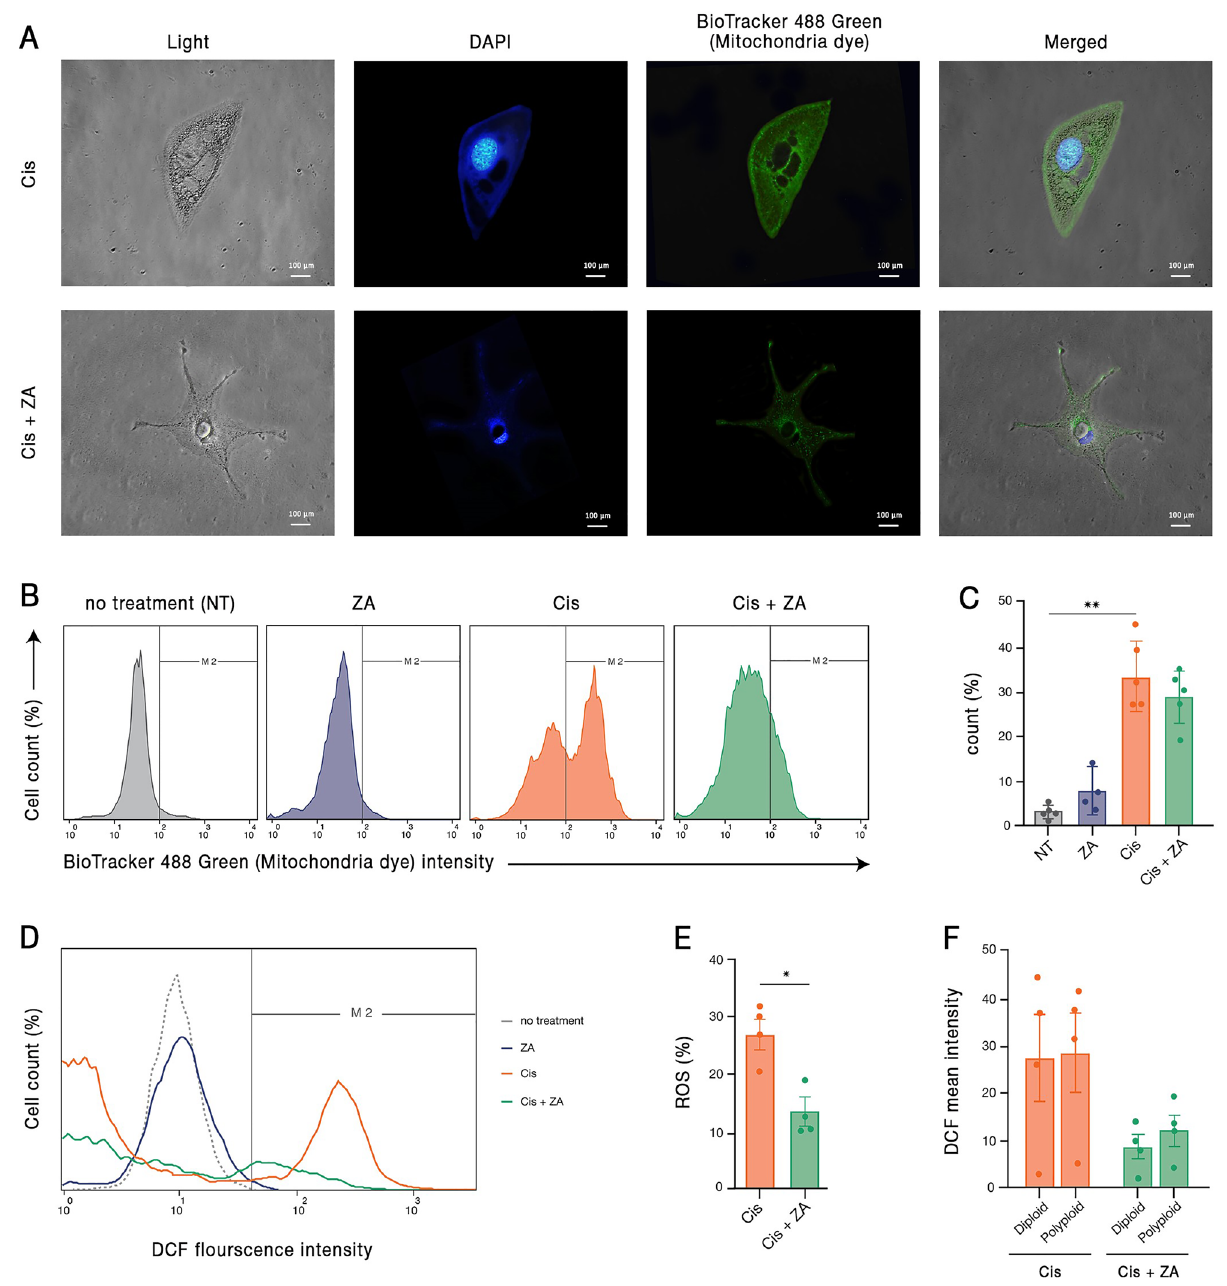
Figure 5. Cisplatin-surviving cells have high mitochondrial density and ROS content, both of which are reduced by ZA. ( A ) Representative images of mitochondrial staining of cancer cells treated with cisplatin or cisplatin + ZA are demonstrated. ( B ) Representative flow-cytometry graphs and ( C ) quantification of four independent experiments demonstrated the augmentation of mitochondrial density after cisplatin and the partial declining effect of ZA. ( D , E ) ROS content of cisplatin-survived cells is increased and is significantly diminished after ZA administration. ( F ) The effect of ZA in declining ROS in cisplatin-treated cells is observed both in diploid and polyploid sub-populations. * p- value < 0.05; ** p- value < 0.01; error bars: mean ±